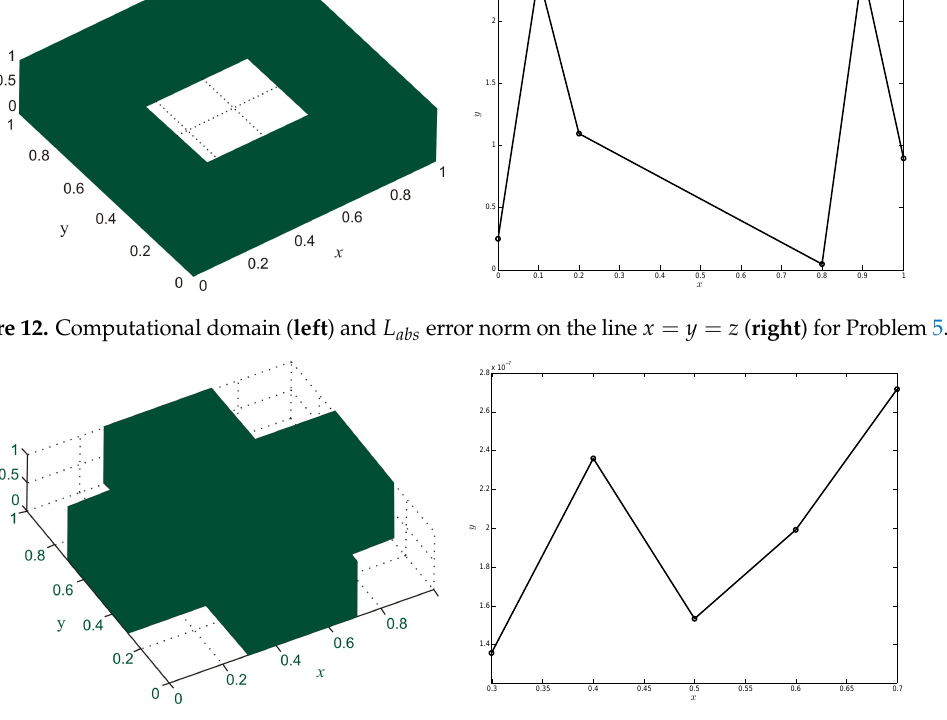
Figure 13. Computational domain ( left ) and L abs error norm on the line x = y = z ( right ) for Problem